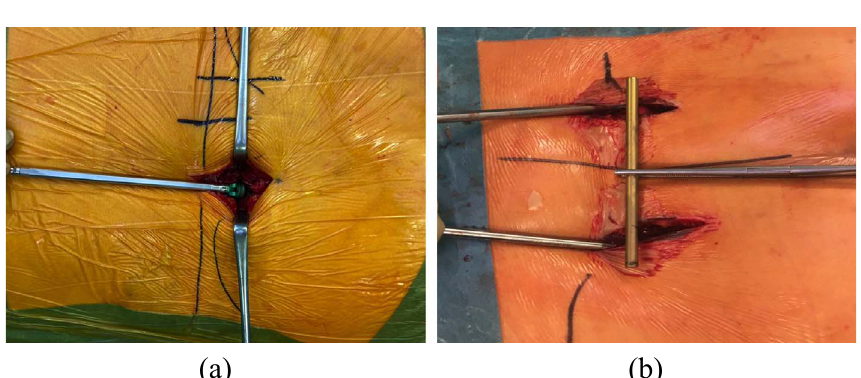
Figure 2. (a) In situ placement of the fi rst pedicle screw (Univeral Spine System II; Depuy/Synthes, 79224 Umkirch, Germany). (b) TIFI after placement of both pedicle screws and before introducing the crossbar